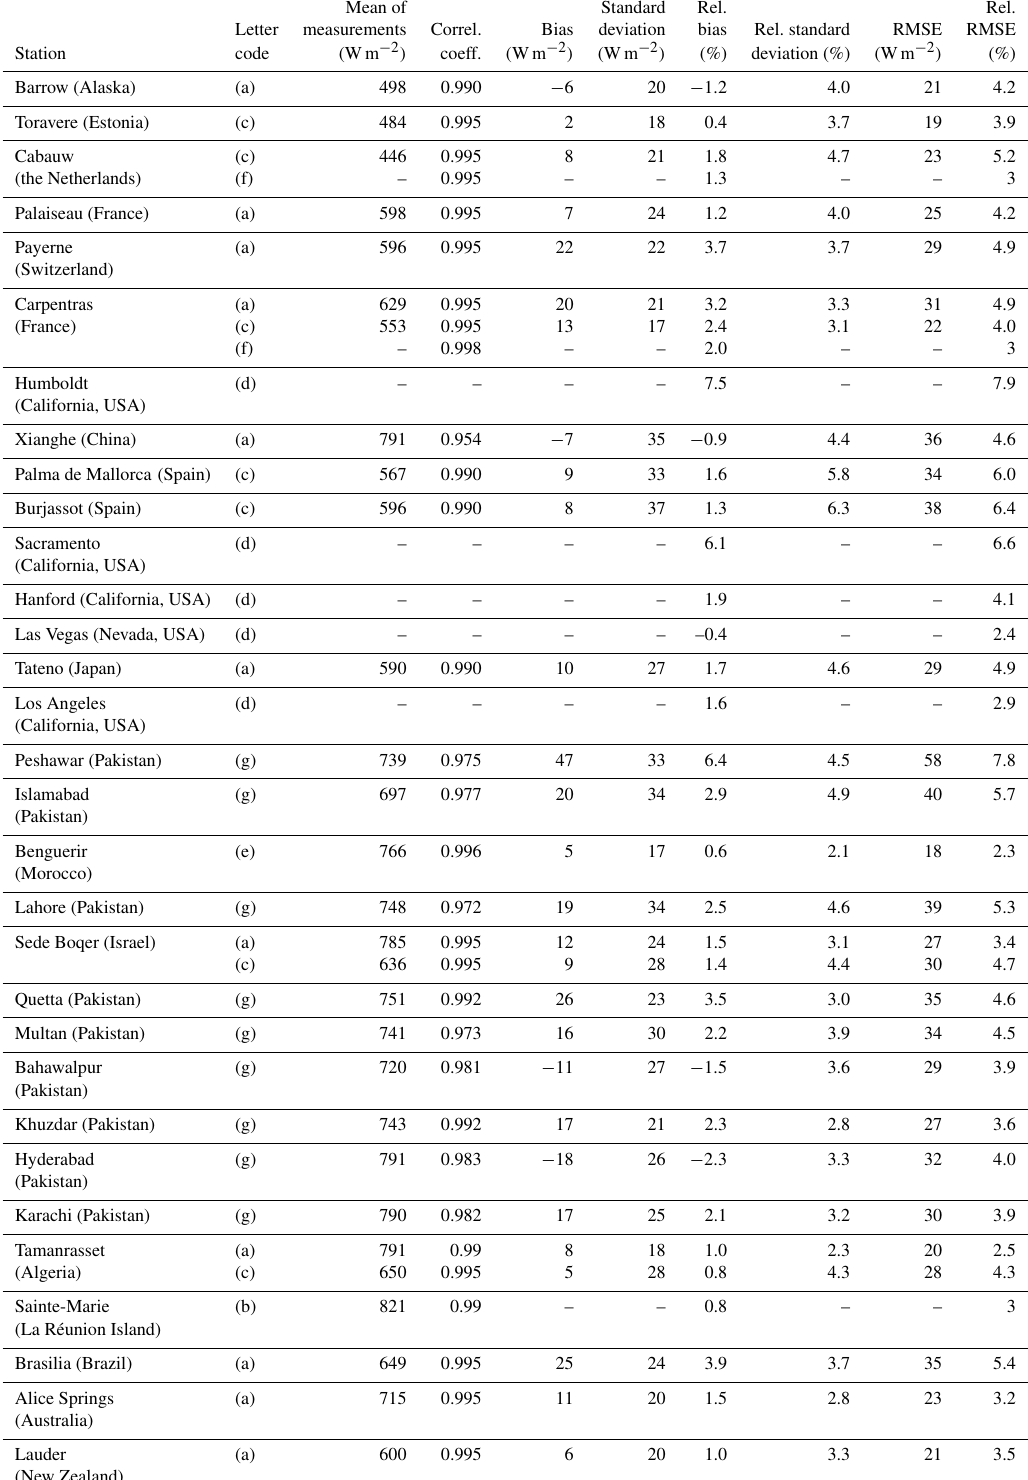
Table B1. Results from previous works at summarization 1min. Means of the measurements, correlation coefficients, bias, standard devia- tions, RMSE, and their values relative to the mean of the measurements for G . Mean of Standard